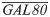
Identification of the underlying Boolean function of the regulatory effects of GAL4 and GAL80 on SWI5 in a synthetic network in Yeast.A: The full schematic diagram of the synthetic network. B: The regulatory interactions in the absence of galactose (culturing cells in glucose) and the corresponding SPSD and the identified Boolean function, i.e., (GAL4)AND(GAL80¯). In the SPSD, RF1 and RF2 refer to GAL4 and GAL80, respectively. C-D: The regulatory interactions in the presence of galactose in the cases of the dissociation and the non-dissociation model, respectively. In both cases of C and D, the identified Boolean function only reflects the activatory effect of GAL4 on SWI5, i.e., GAL4→SWI5, despite the existing PPI between Gal4 and Gal80 in D.